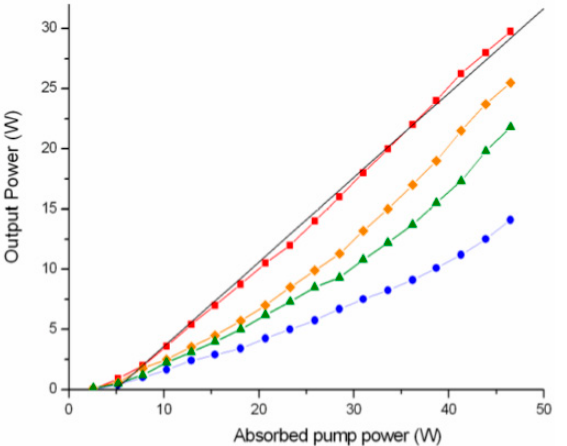
Figure 5. Absorption spectra of an unphotodarkened LMA Yb-doped fiber (red curves) and of the same fiber at different states of PD at 7 min, 15 min, and 100 min (orange, green, and blue) of pumping the fiber by the light of 45 W at 976 nm. Adapted with permission from [2] © The Optical Society.